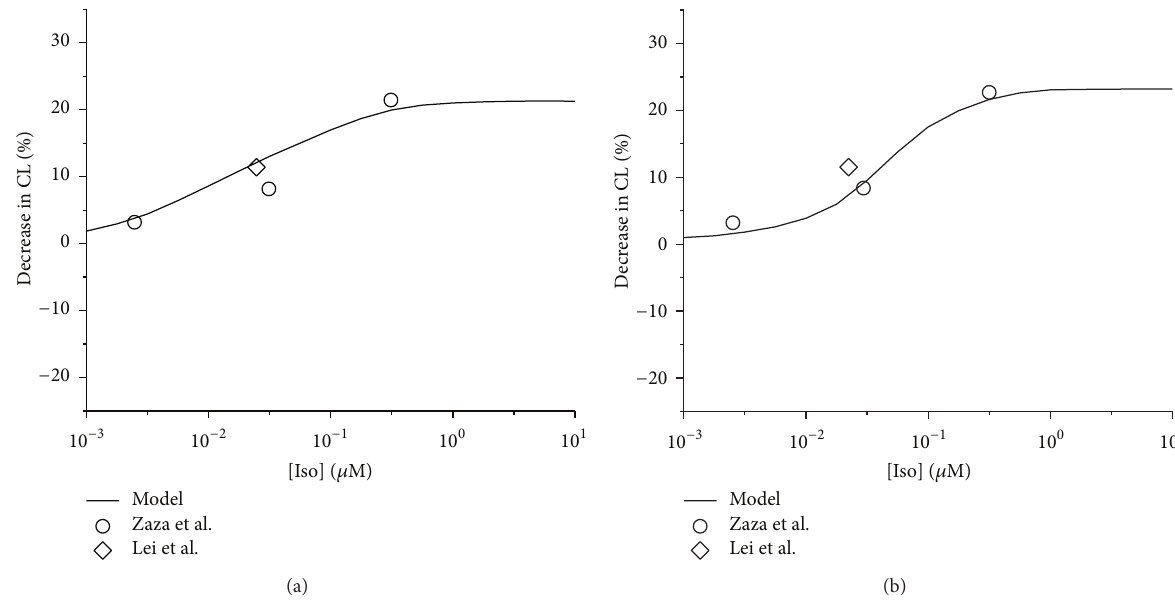
Figure 2: Concentration-dependent percentage decrease of pacemaking CL by Iso. (a) Central cell model and relevant experimental data. (b)Peripheralcellmodelandrelevantexperimentaldata.Opencircles:experimentaldataofZazaetal.fromrabbitSANcells.Opendiamonds: data of Lei et al. from rabbit SAN